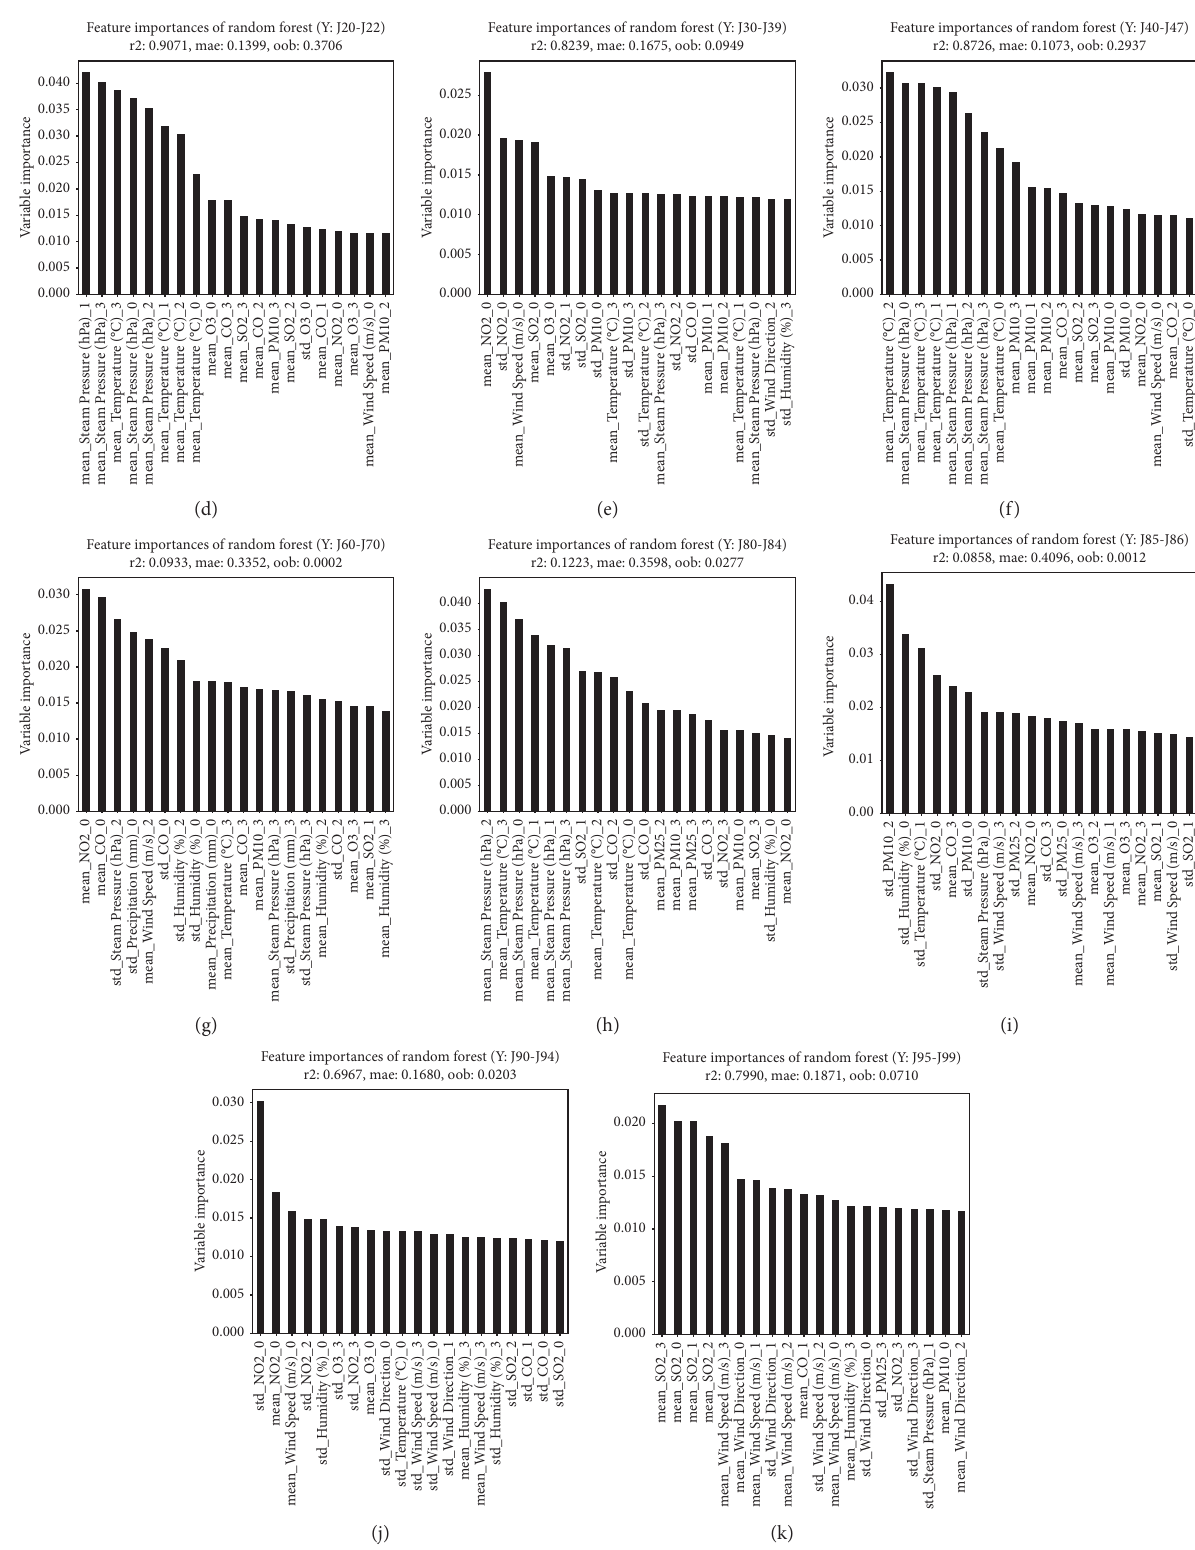
Figure 5: Analysis of the correlation between respiratory disease patients’ visit to the ED and air pollution and weather variables (day 0–3). (a) [J00-J06] Acute upper respiratory infections. (b) [J09-J11] Influenza. (c) [J12-J18] Pneumonia. (d) [J20-J22] Other acute lower re- spiratory infections. (e) [J30-J39] Other diseases of upper respiratory tract. (f) [J40-J47] Chronic lower respiratory diseases. (g) [J60-J70] Lung diseases due to external agents. (h) [J80-J84] Other respiratory diseases principally affecting the interstitium. (i) [J85-J86] Suppurative and necrotic conditions of lower respiratory tract. (j) [J90-J94] Other diseases of pleura. (k) [J95-J99] Other diseases of the respiratory